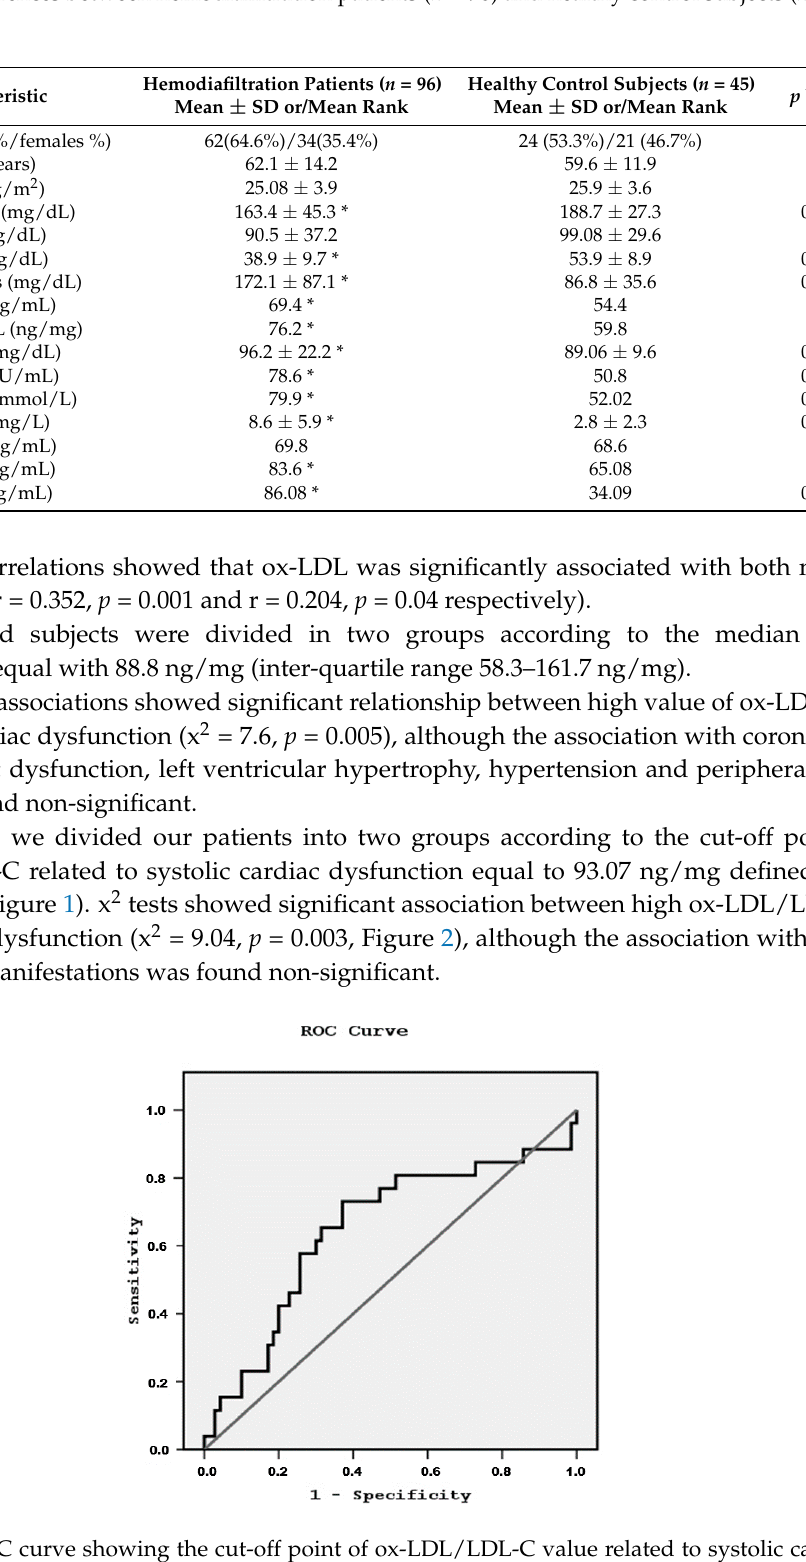
Figure 1. ROC curve showing the cut-off point of ox-LDL/LDL-C value related to systolic cardiac dysfunction equal to 93.07 ng/mg in enrolled subjects ( n = 96).